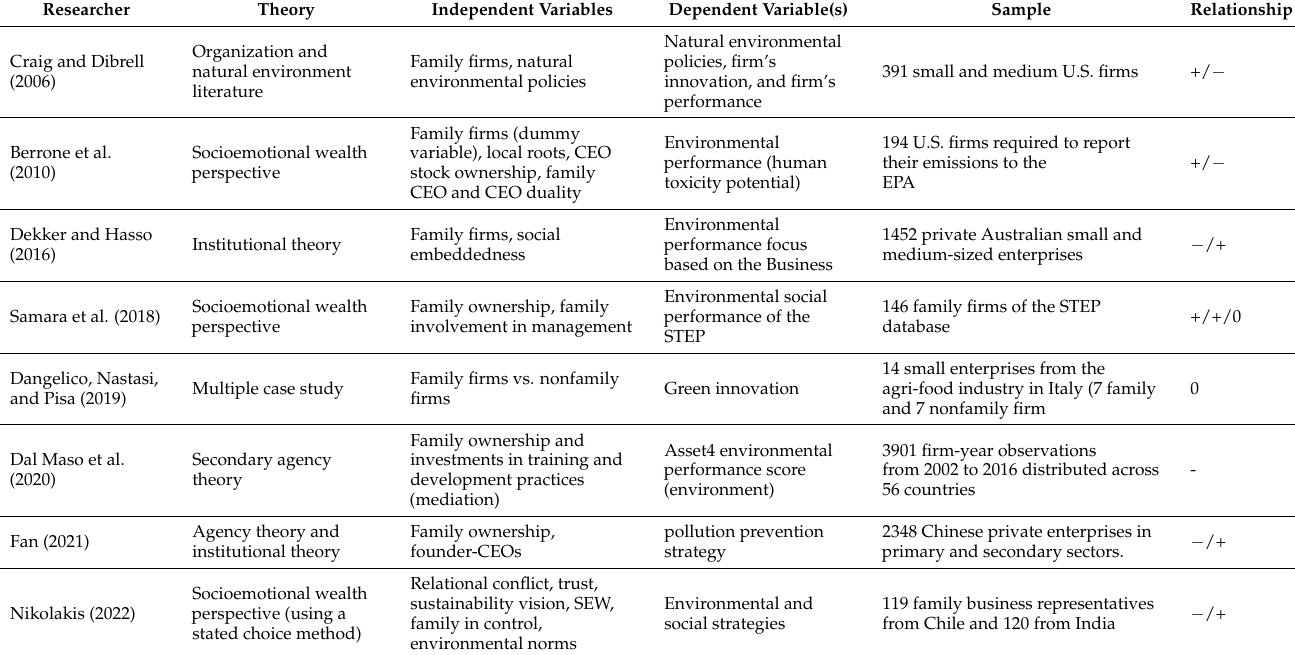
Table 4. Representative literature on the relationship between family firms and corporate environ- mental issues